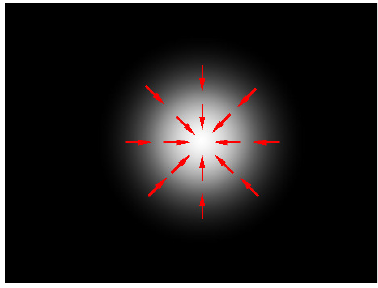
Figure 2. Ideal laser spot; gradient directions are shown in red.